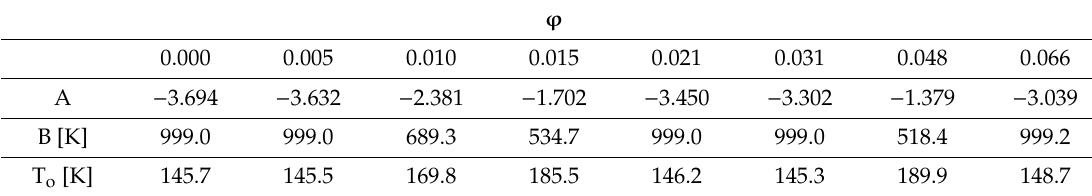
Table 3. Coe ffi cients A, B and T o from Equation (18) for EG-Al 2 O 3 nanofluids